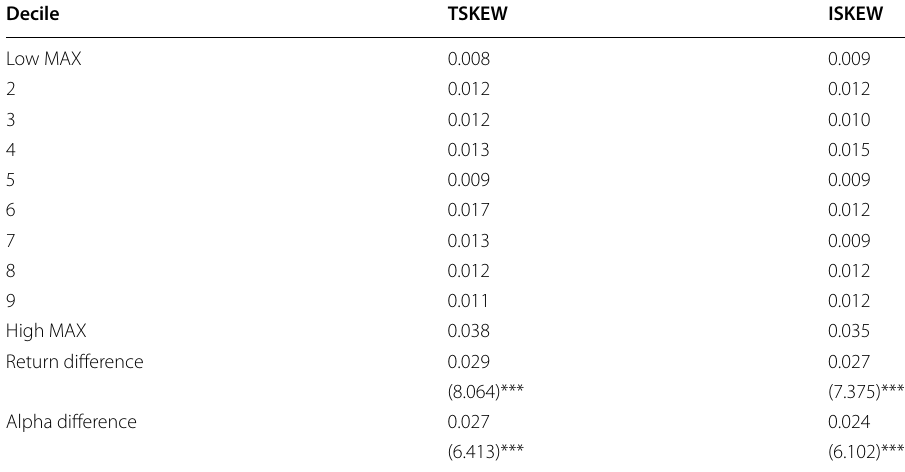
Decile portfolios are formed every week from January 2014 to September 2020 by sorting cryptocurrencies based on the maximum daily returns after controlling for total (TSKEW) and idiosyncratic (ISKEW). In each column, we first rank cryptocurrencies based on the skewness variable (TSKEW and ISKEW), then within each decile, we sort cryptocurrencies into decile portfolios of MAX. Decile 1 (10) is the portfolio of cryptocurrencies with the lowest (highest) maximum daily return over the previous month. Table presents the value‑weighted (VW) average weekly returns. The bottom two rows report the differences in weekly returns and the differences in three‑factor alphas between portfolios 10 and 1, and the corresponding t‑statistics. Newey‑West (1987) adjusted t‑statistics are presented in parentheses ***, ** and * denote significance at 1%, 5% and 10%,